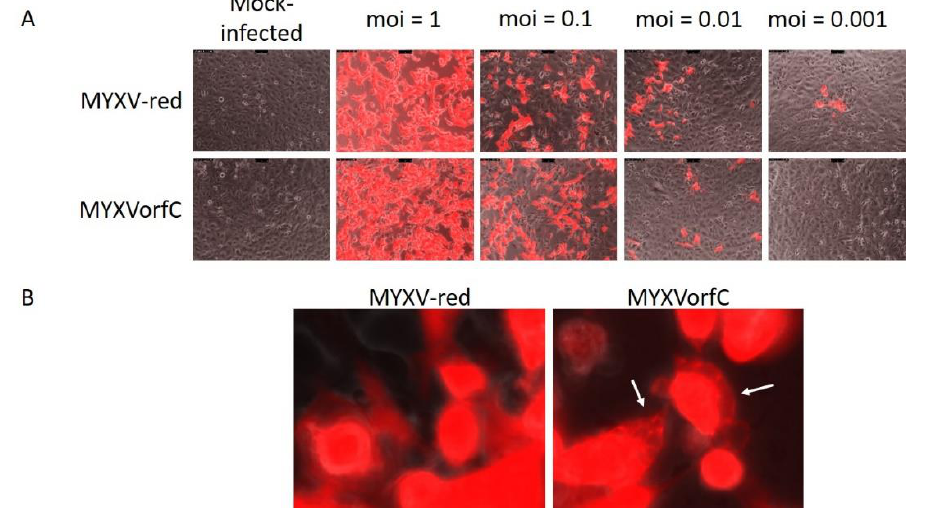
Figure 4. Expression of tdTomato by recombinant MYXV (moi = multiplicity of infection). ( A ) Representative images of infected RK-13 cells 24 hpi (100× magnification). No significant differences in the number of infected cells were observed. ( B ) Morphologic differences in viral plaques grown on RK-13 cells (moi = 0.01, 48 hpi). Some MYXVorfC-infected cells contained large cytoplasmic vacuoles (arrows) which were not detected in cells infected with MYXV-red (800× magnification). Data were repeatable ( n > 3).